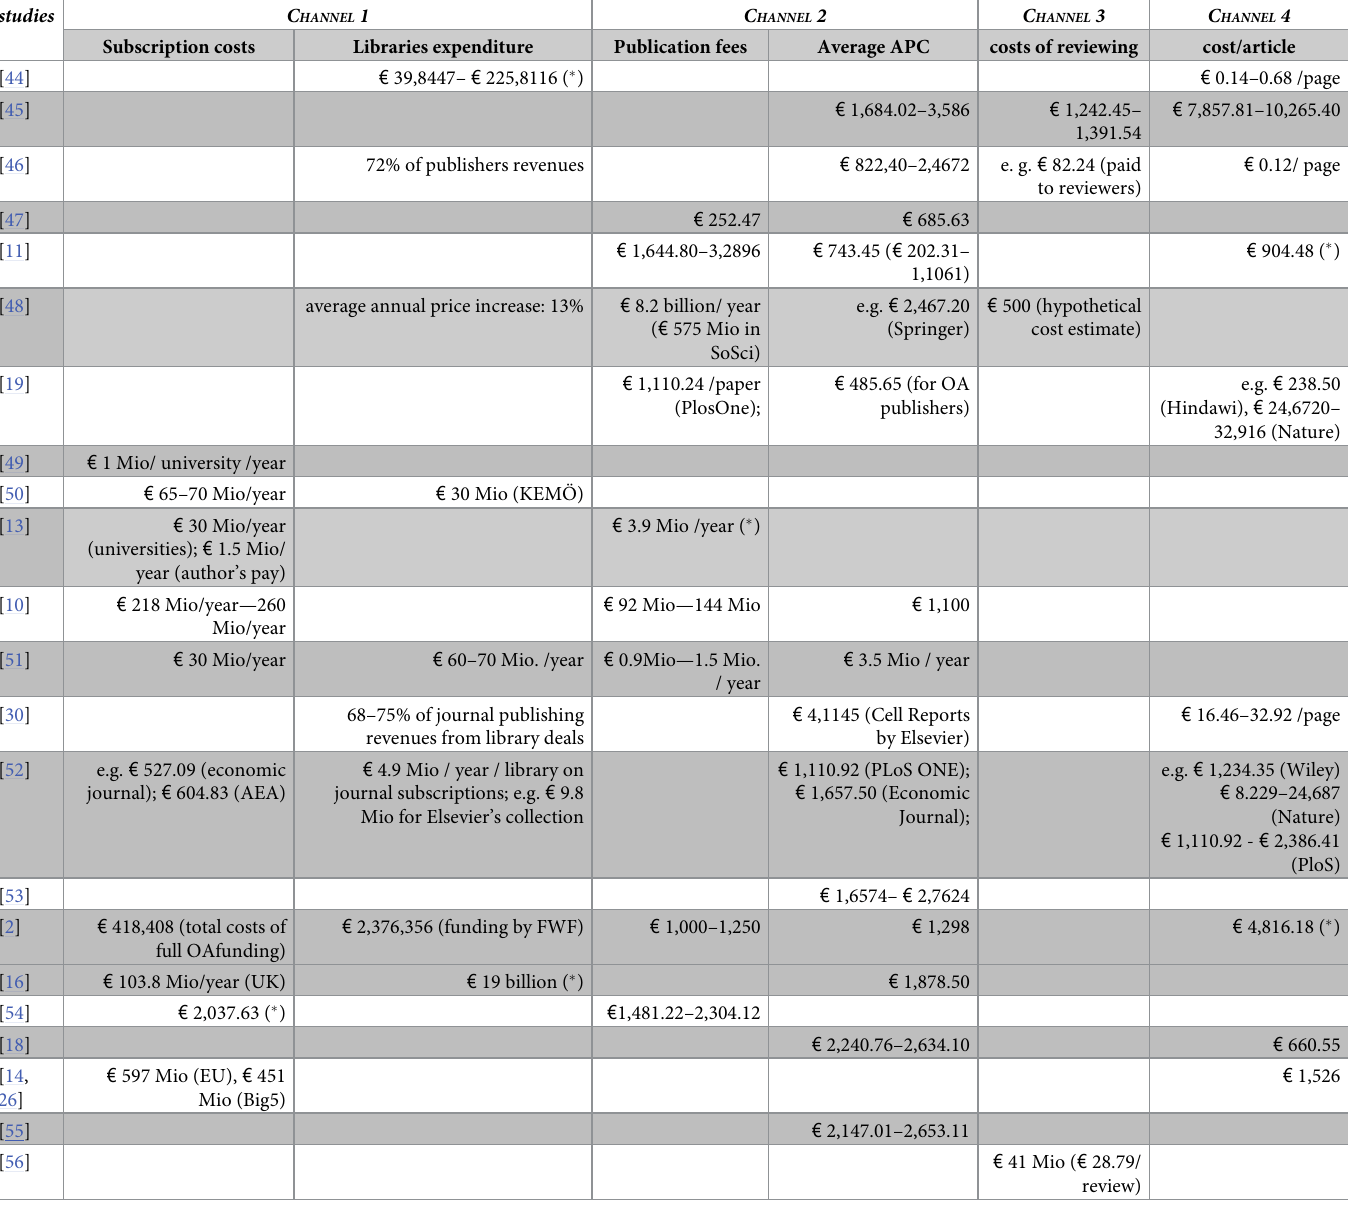
Table 1. Studies on costs and expenditures in the field of academic